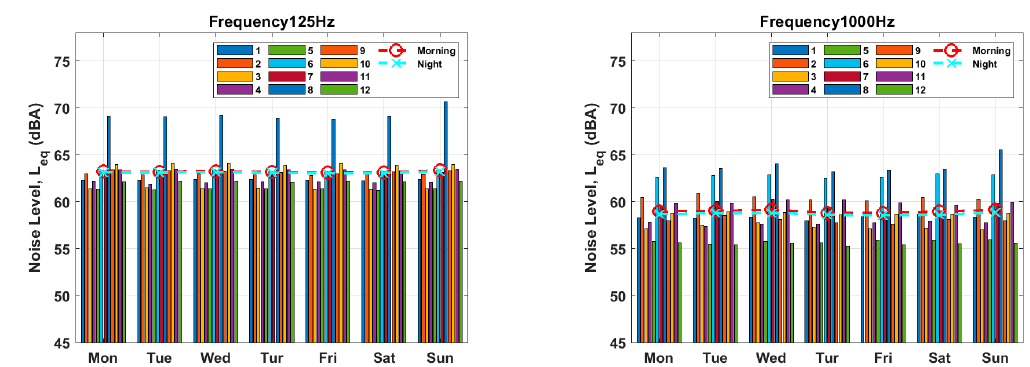
Figure 6. Daily average at 125 Hz and 1000 Hz in one week for different sensors.